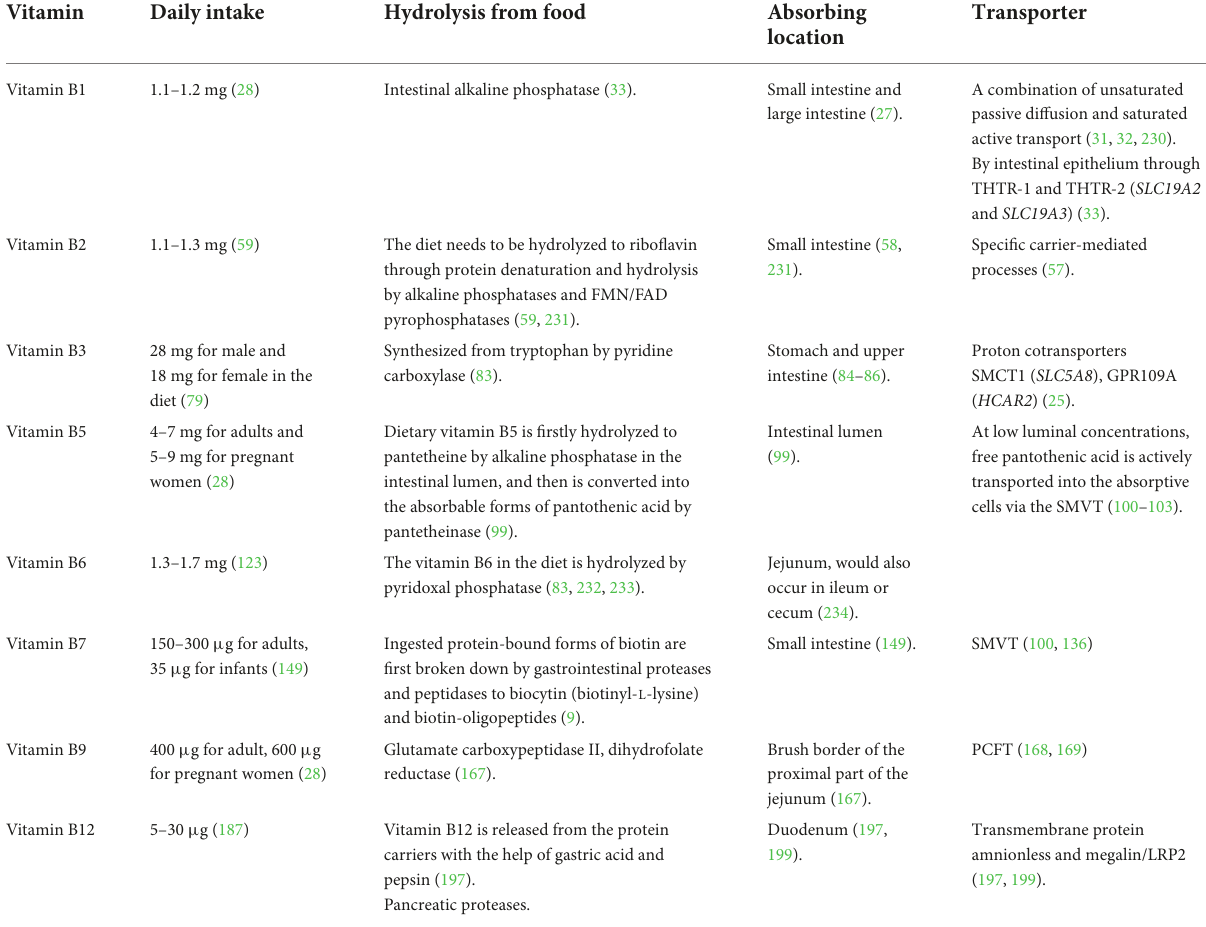
TABLE 1 Summary of vitamin B absorption